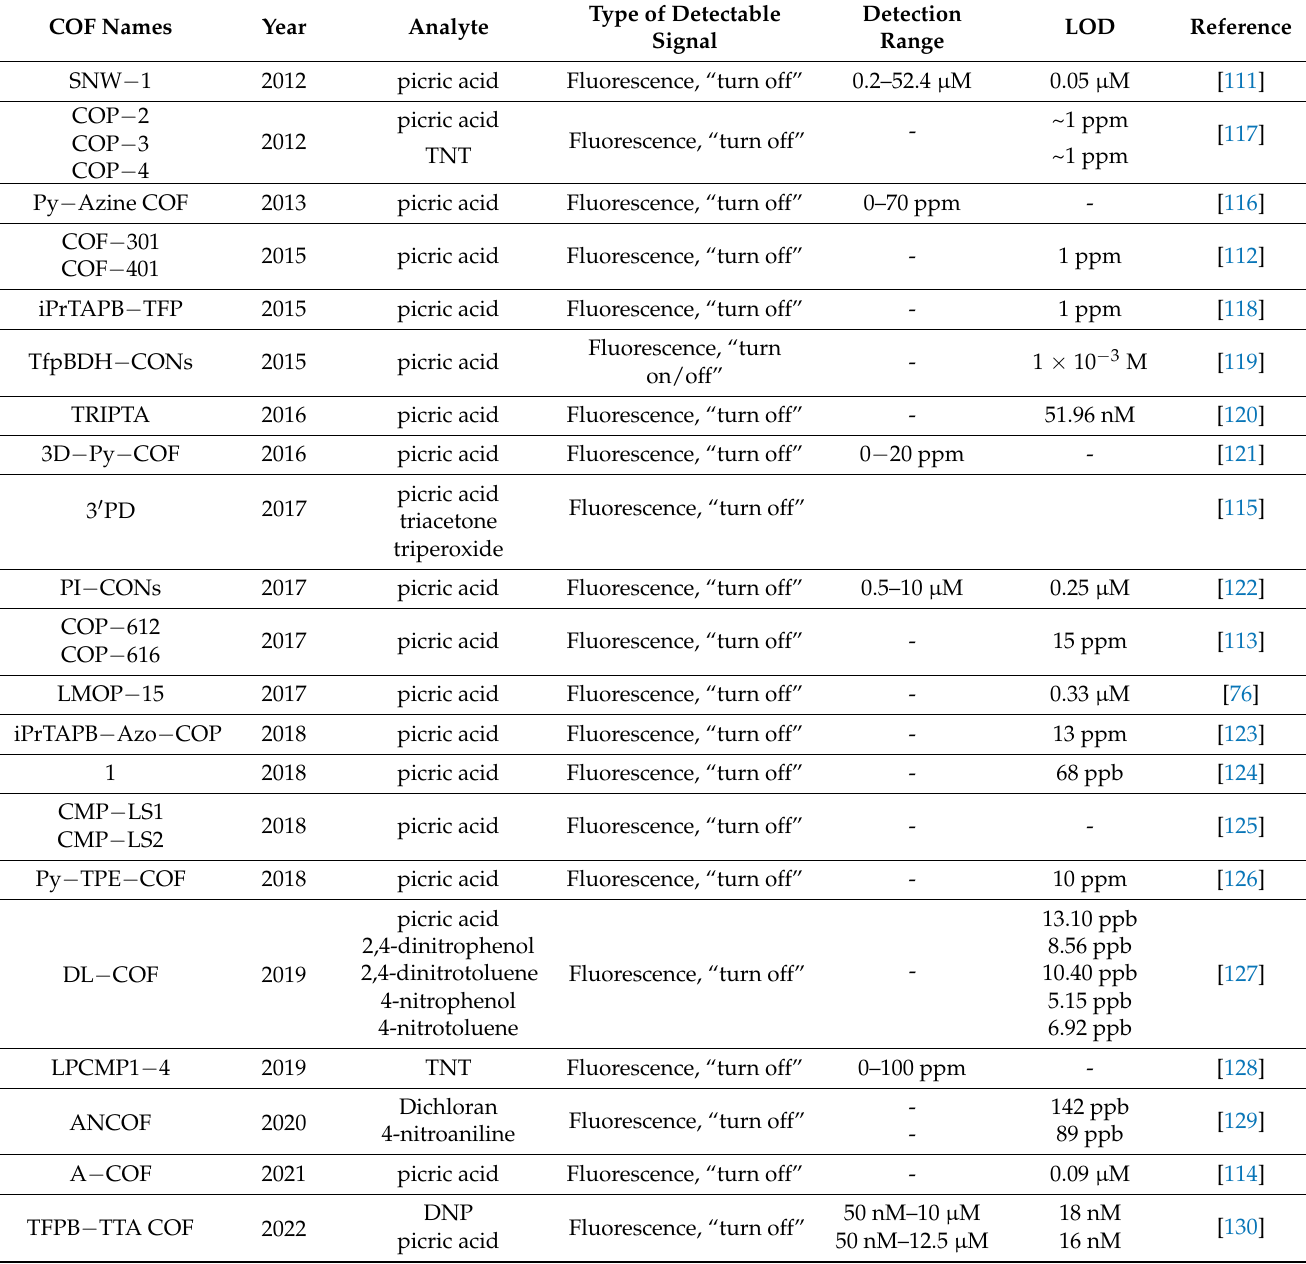
Table 6. COF-based explosive